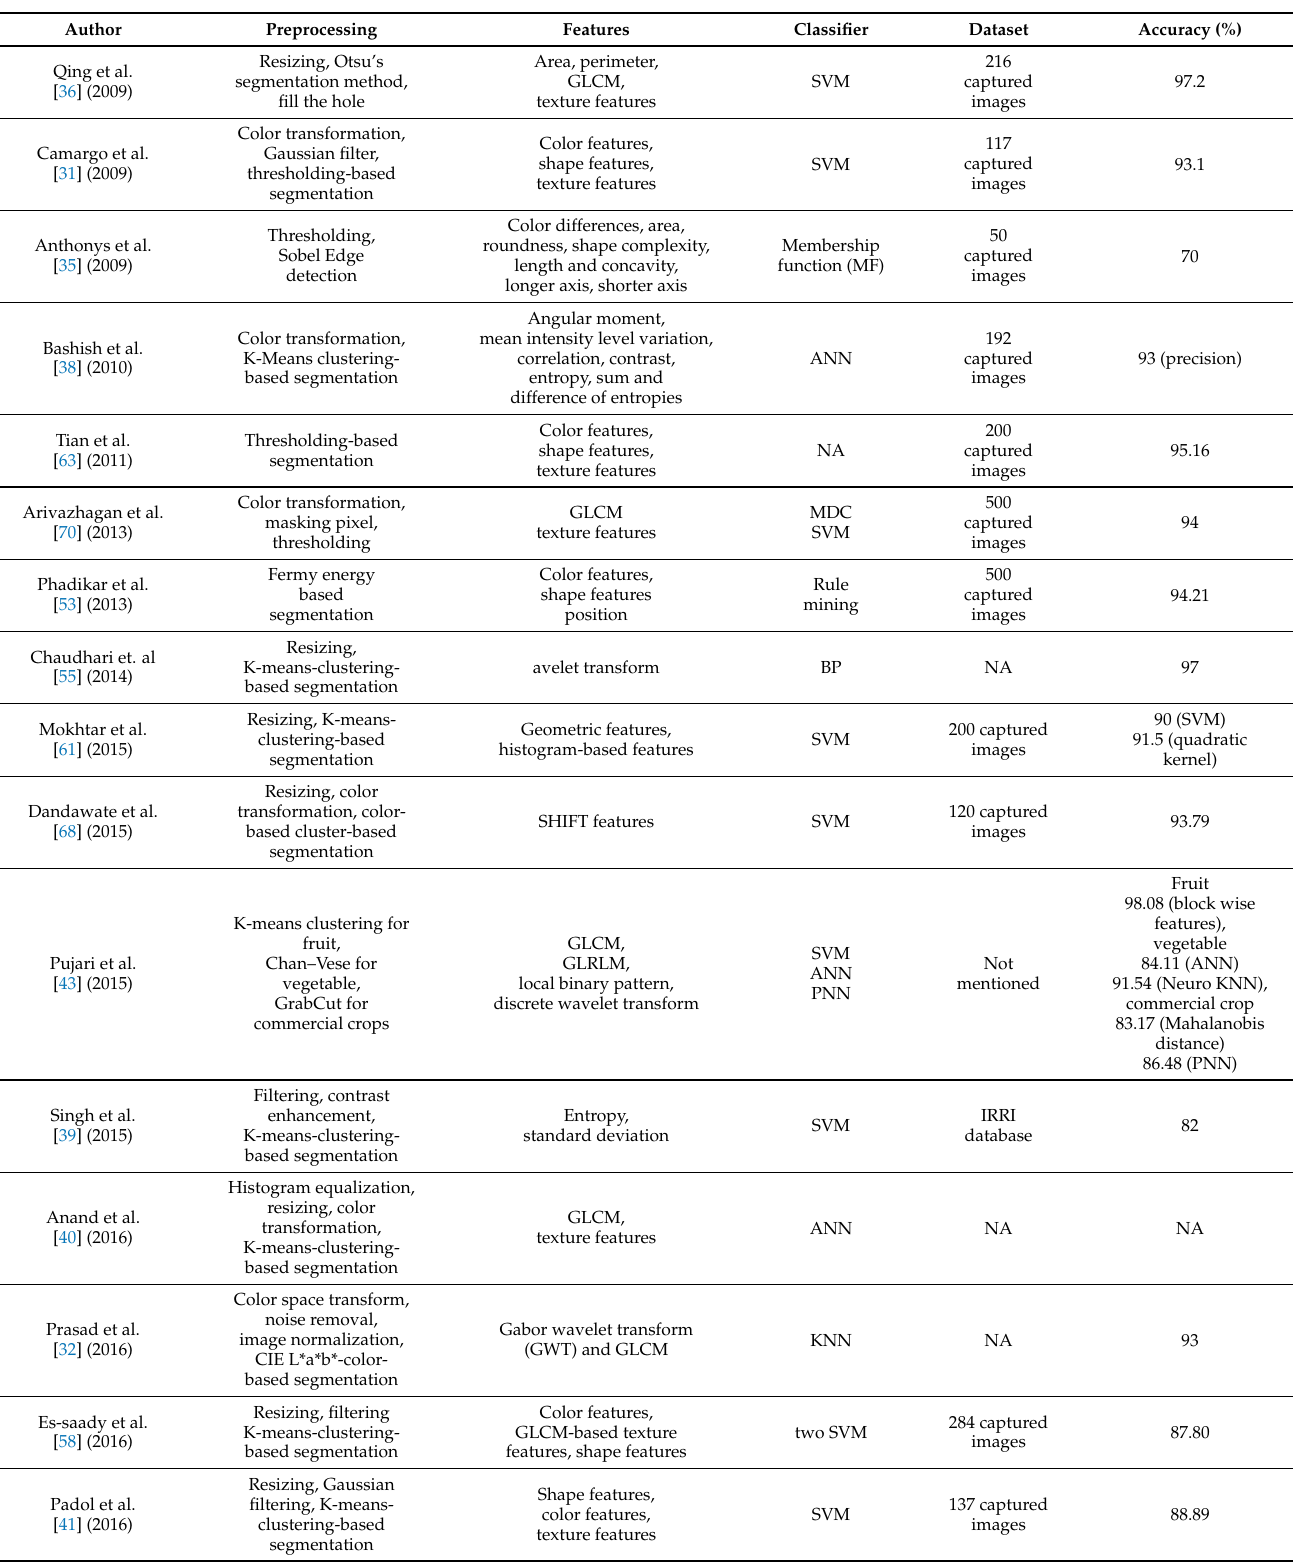
Table 4. Summary of implemented methods based on shape and